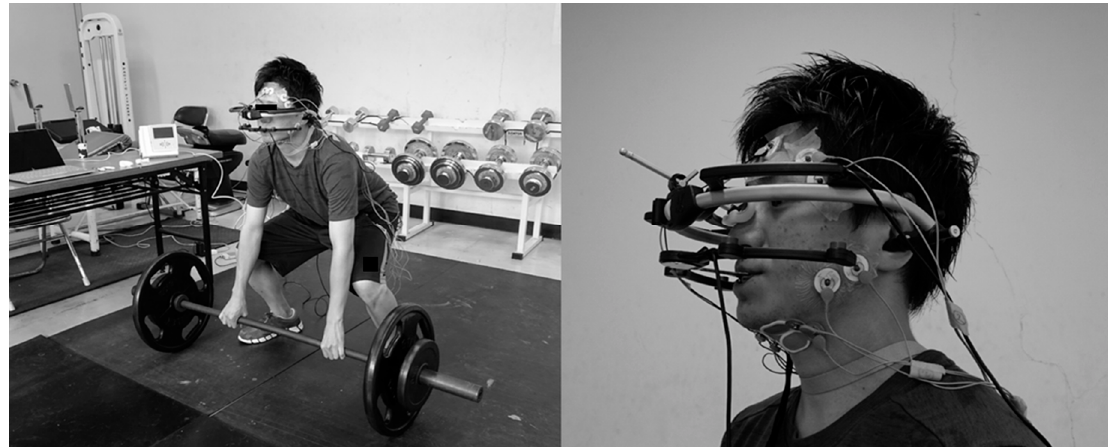
Figure 1. Measurement of mandibular jaw movement and electromyographic activity of the masticatory muscles during deadlift.